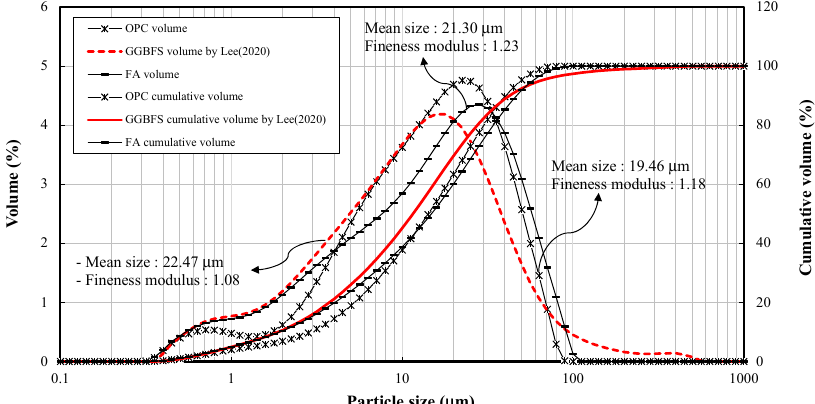
Figure 1. The particle size distributions of OPC and FA compared with ground-granulated blast-furnace slag (GGBFS) by Lee, adapted from [26].